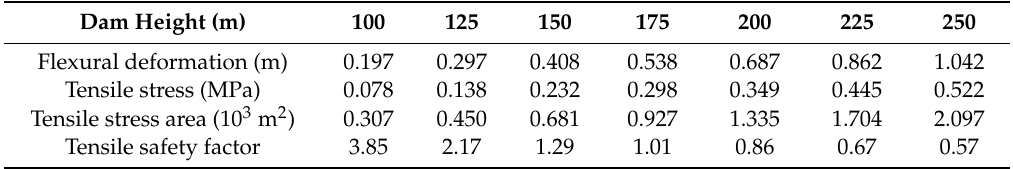
Figure 22. Relationship between tensile stress area maximum of SACC and dam height. Table 7. Flexural deformation, tensile stress, tensile stress area, and tensile safety factor of SACC with di ff erent dam